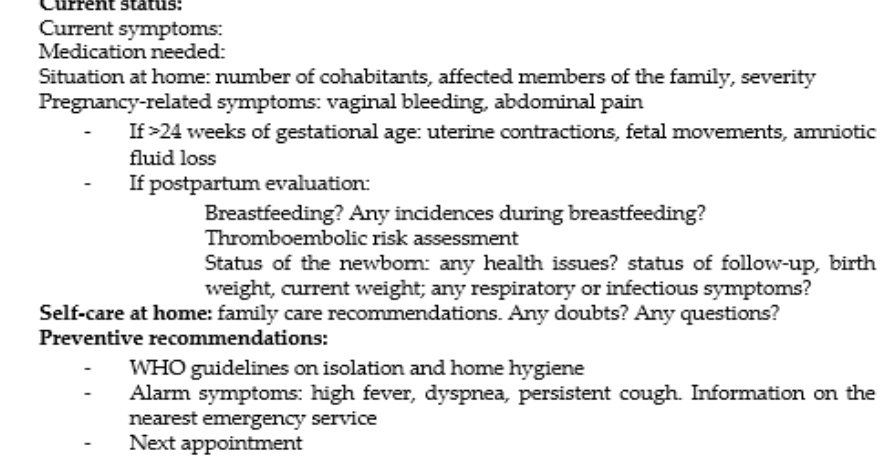
Figure 2. Semi-structured questionnaire.